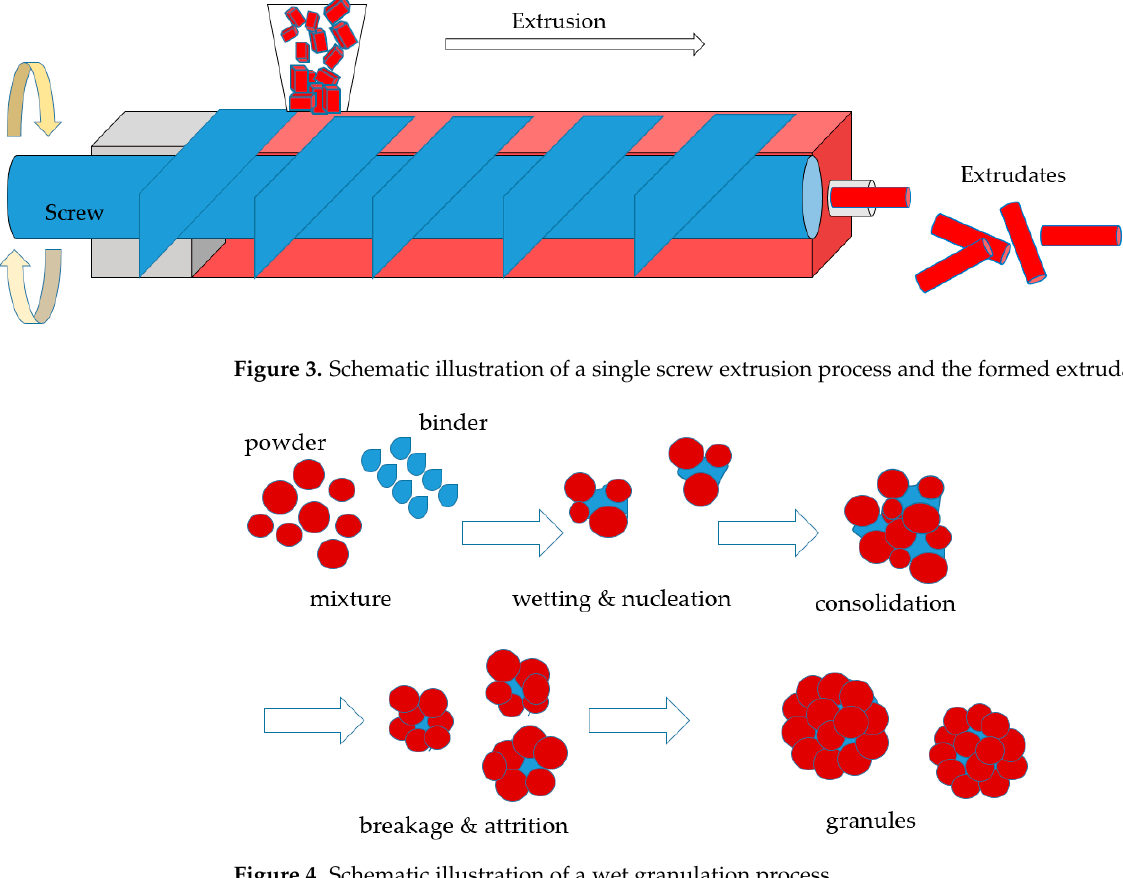
Figure 4. Schematic illustration of a wet granulation process.